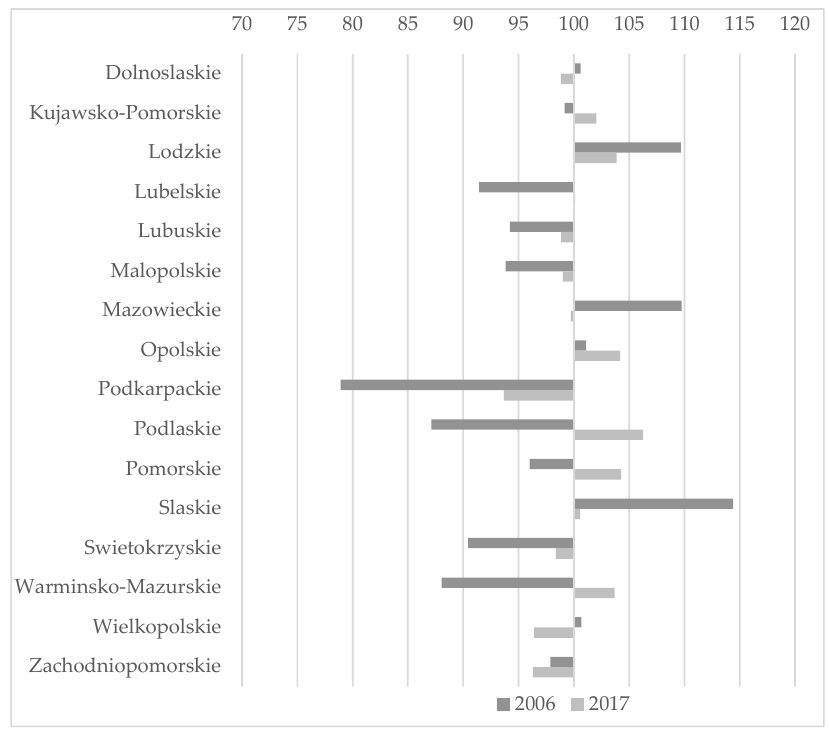
Figure 3. Total difference in CO 2 emission per capita in regions of Poland compared to the average (Poland = 100). Source: Own calculation.